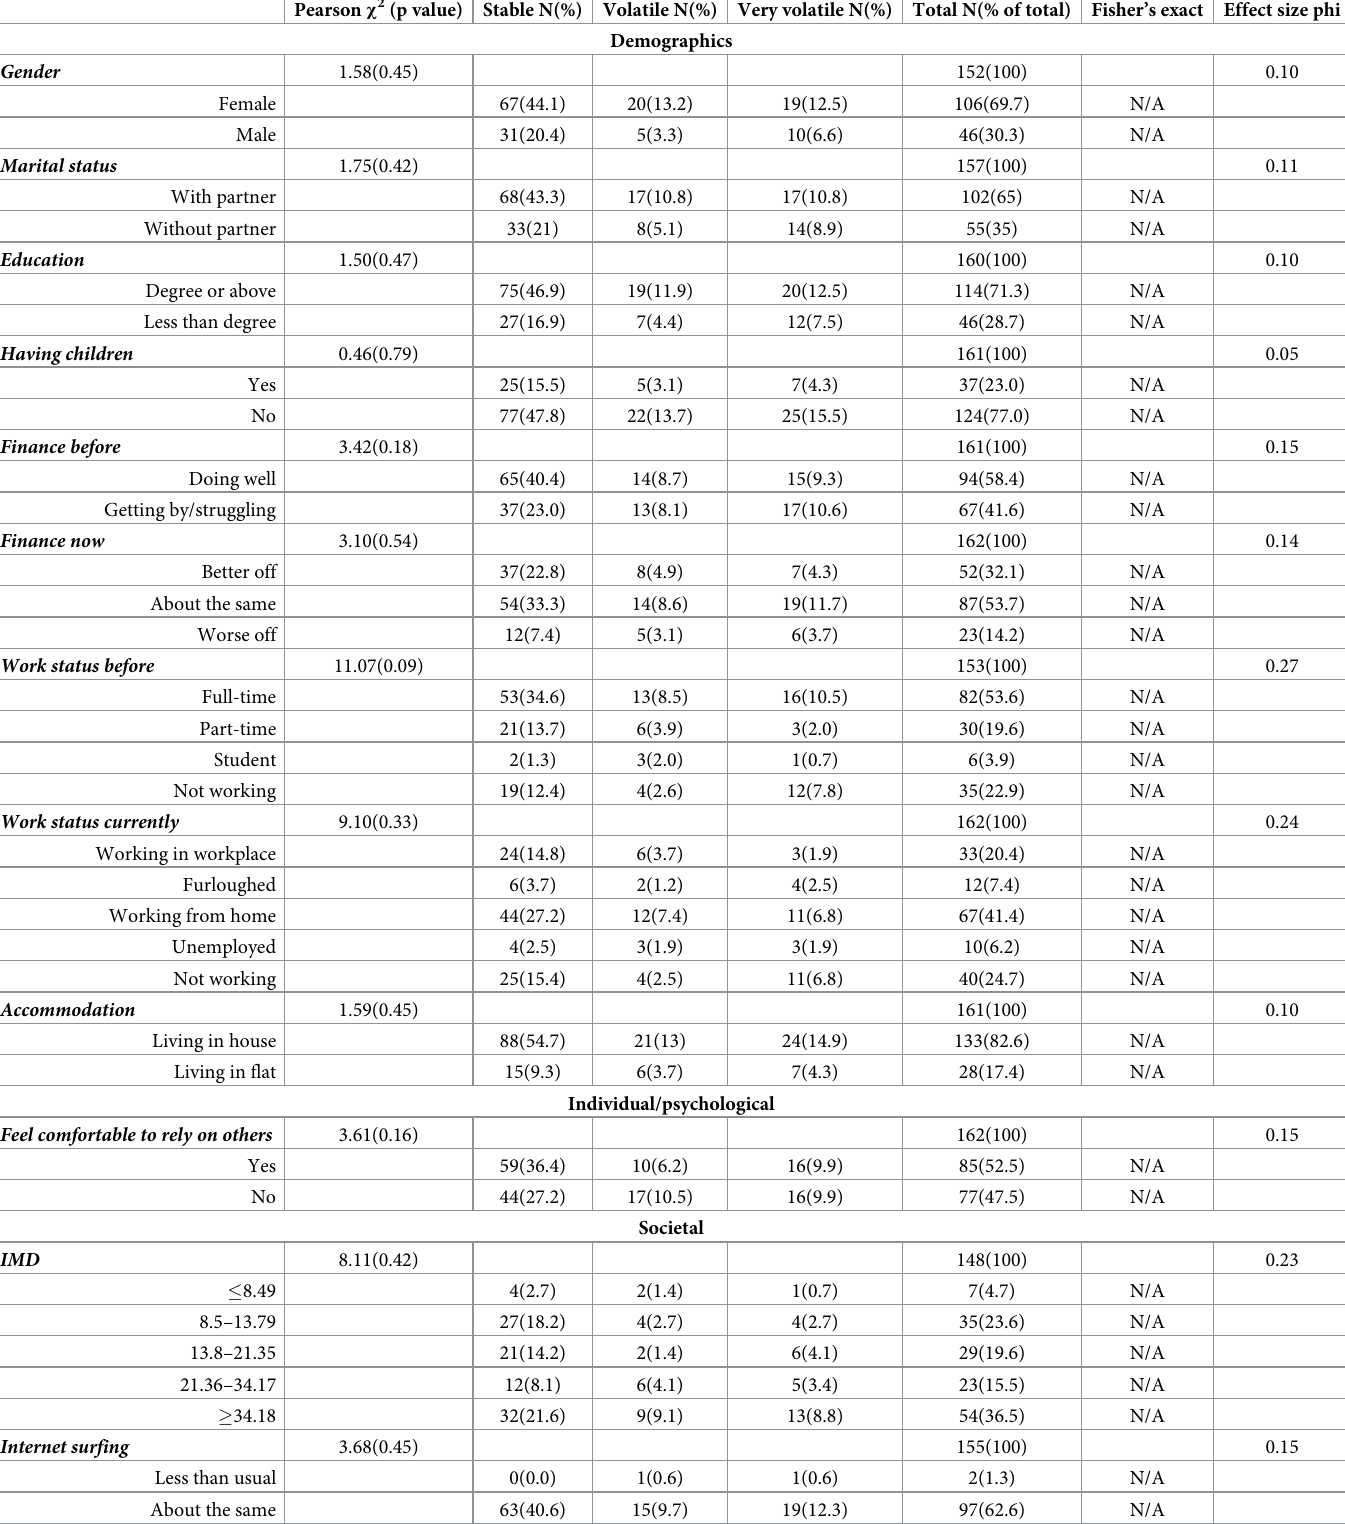
Table 6. Differences between the ‘stable’, ‘volatile’, and very volatile groups analysing categorical variables. Significant differences are